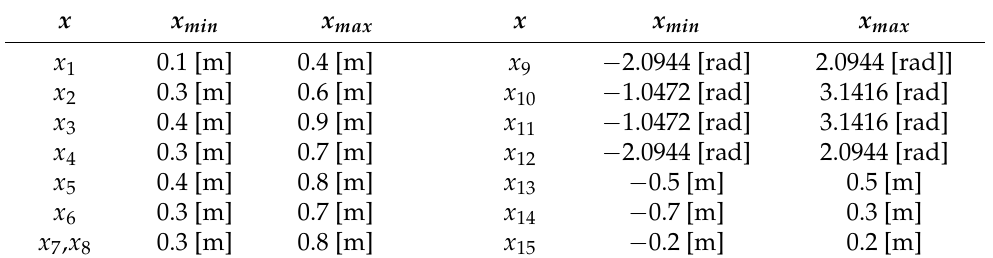
Table 3. The maximum and minimum parameters of the vector x for the cam-linkage